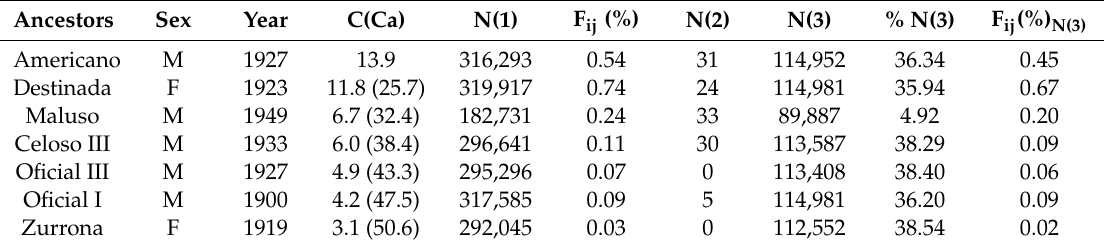
Table 2. Ancestors accounting for 50% of the genetic variability of the total Pura Raza Español horse (PRE) population. The table shows their contribution, the number of total descendants, those with an F ij value over 6.25%, the number and percentage of descendants in last generational interval, total average F ij and the average F ij they transmit to the last generational